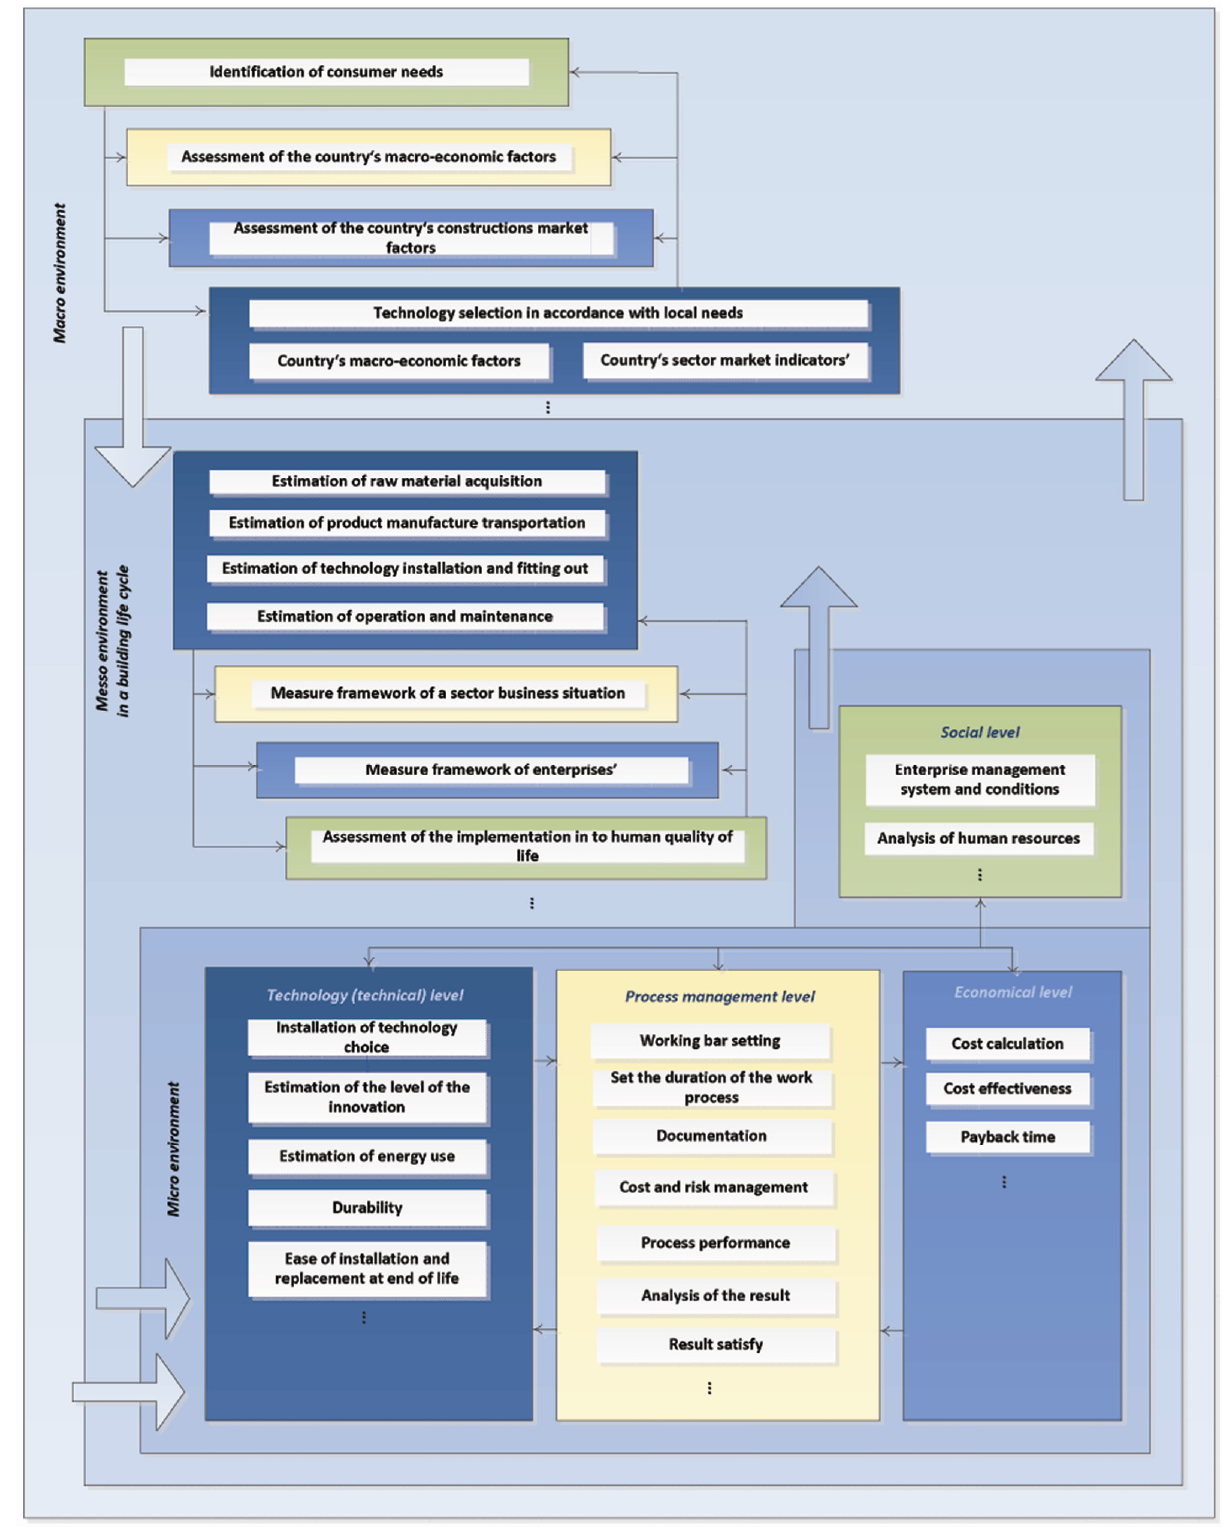
Fig. 3. Detail complex assessment model for advanced technology